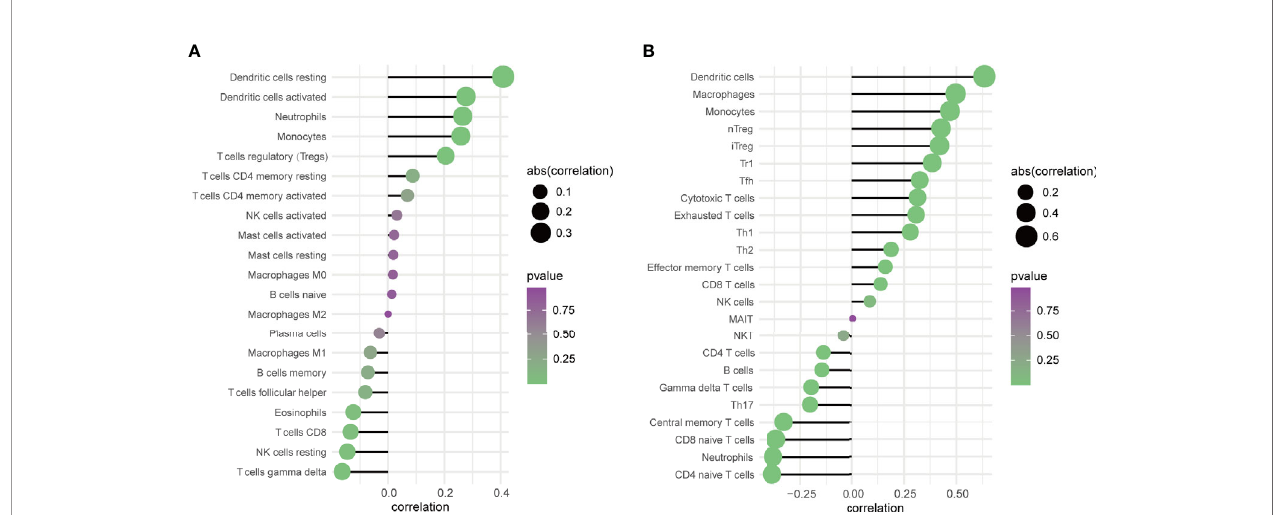
FIGURE 4 | The relationship between TREM-1 and immune cells in PTC. (A) Correlation analysis between TREM-1 expression and the proportion of immune cells in PTC (CIBERSORT, n=259). (B) Correlation analysis between TREM-1 expression and the abundance of immune cells in PTC (ImmuCellAI,